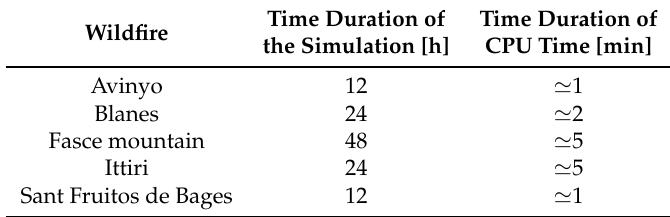
Table 3. Time duration of the